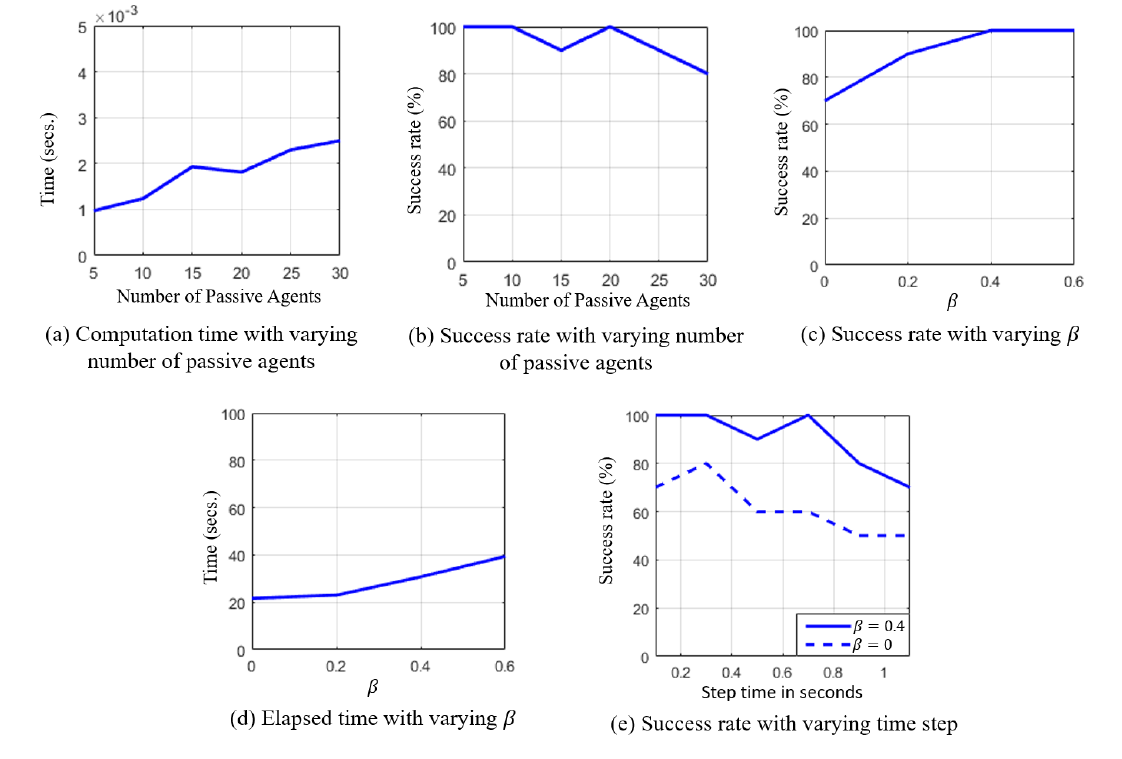
Figure 8. In this graph, the performance of the proposed algorithm for a car-like robot is presented for the set of three parameters, the number of passive agents present, minimum saftey margin β , and the length of the time step. The effects on computation time, success rate, and elapsed time, are